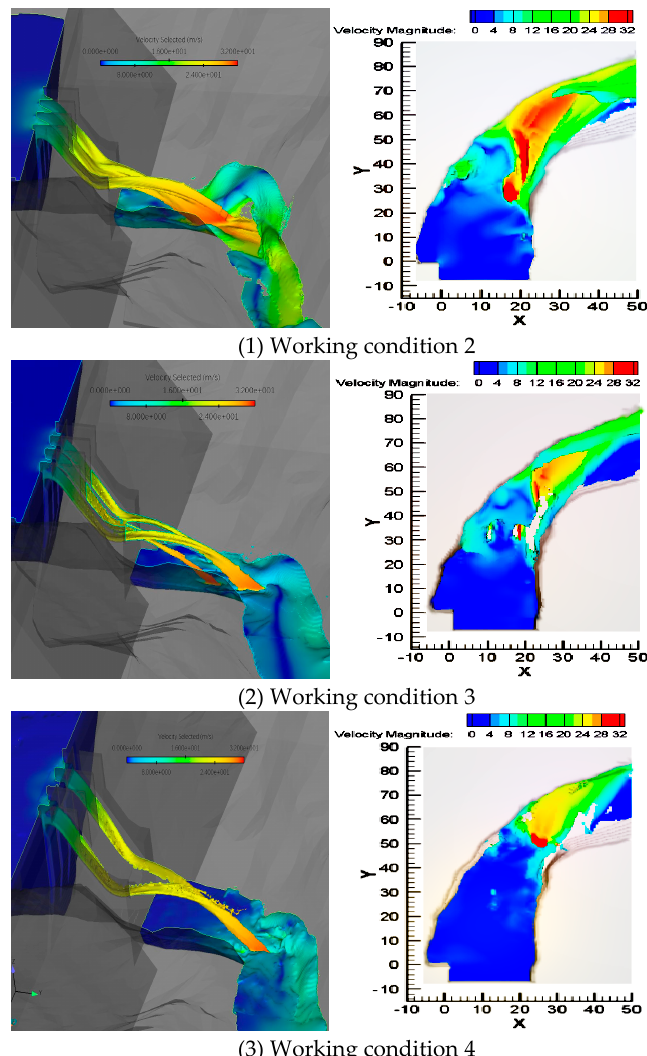
Figure 12. Flow patterns and the position of nappe entry into the downstream channel for each working condition.